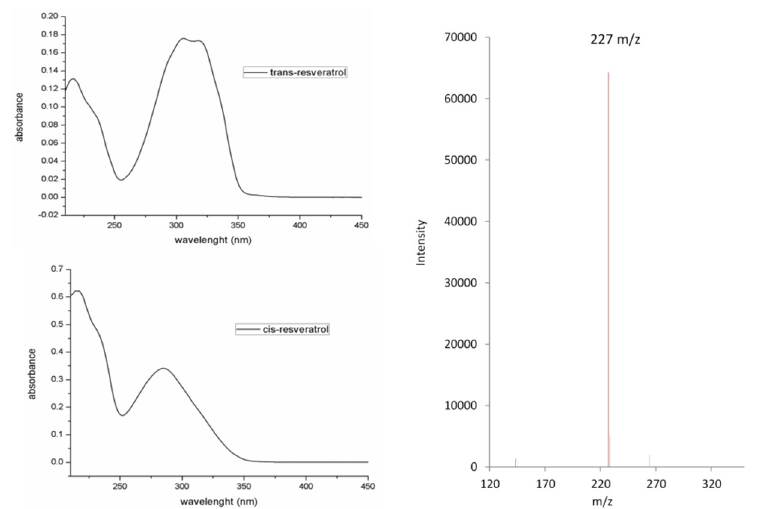
Figure 4. trans - and cis -Resveratrol UV-visible spectra ( left ) and ESI-MS negative mode spectrum ( right , same pseudo-molecular m/z value for cis- and trans- isobars).